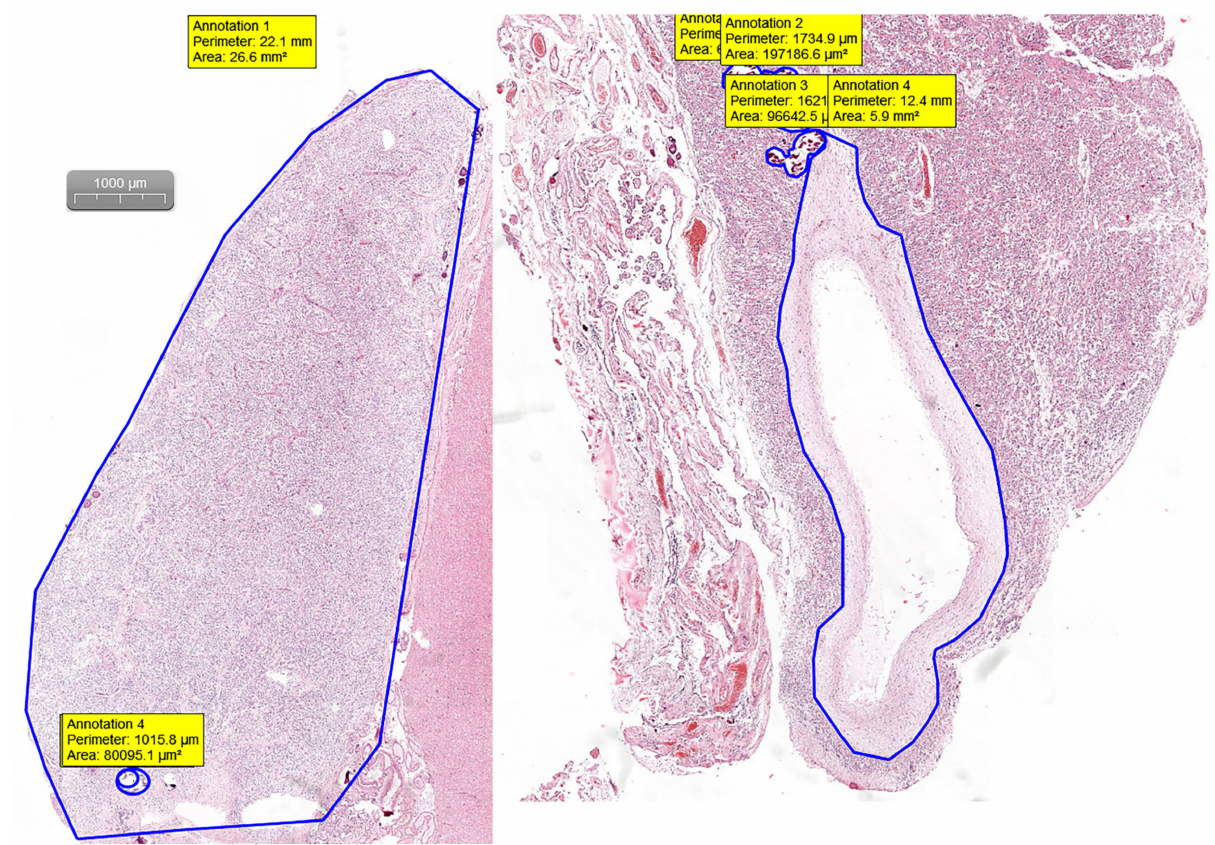
Figure 1. H&E digital slides used for measuring the perimeter and area using the “draw closed polygon” tool in CaseViewer by 3DHISTECH (Budapest, Hungary)